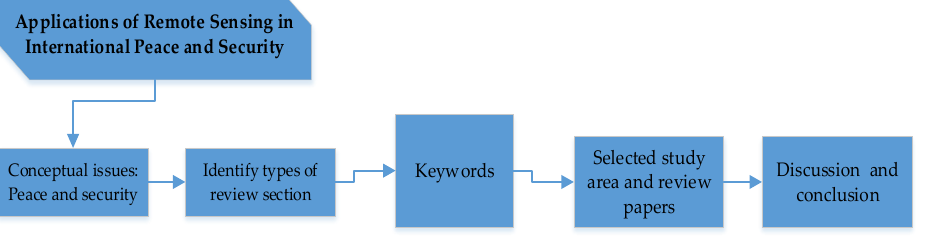
Figure 2. Flowchart of literature review.